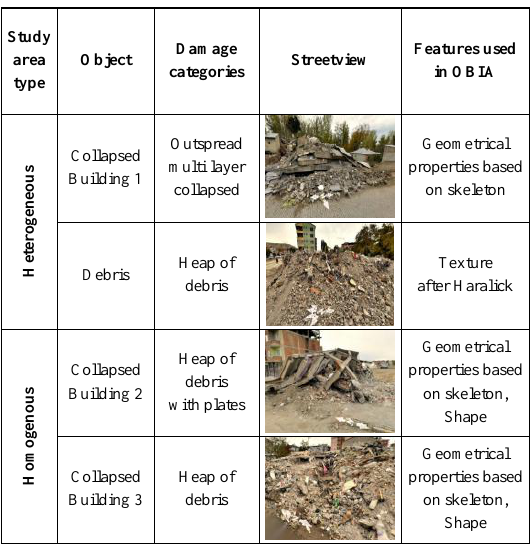
Table 3: Relationship between damage categories